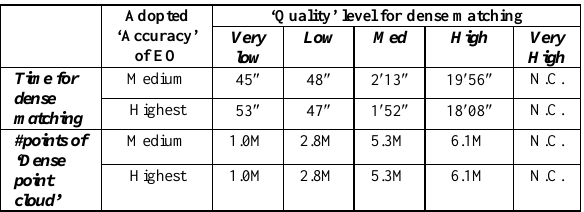
Table 3. Statistic on the dense matching of ‘Test block’ using different configurations for ‘Dense point cloud’ generation in APP and two sets of computed EO